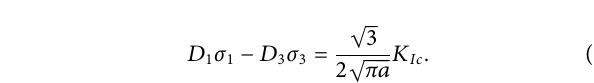
Frontiers in Earth Science |